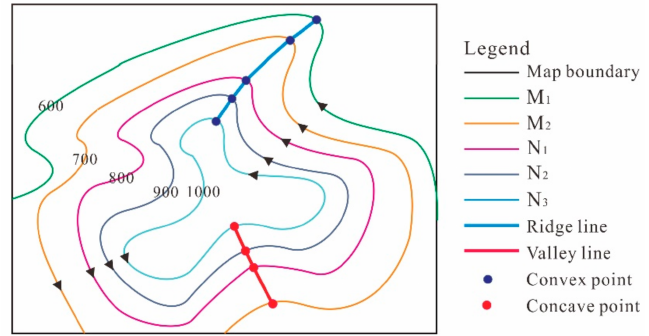
Figure 8. Identification of concave or convex